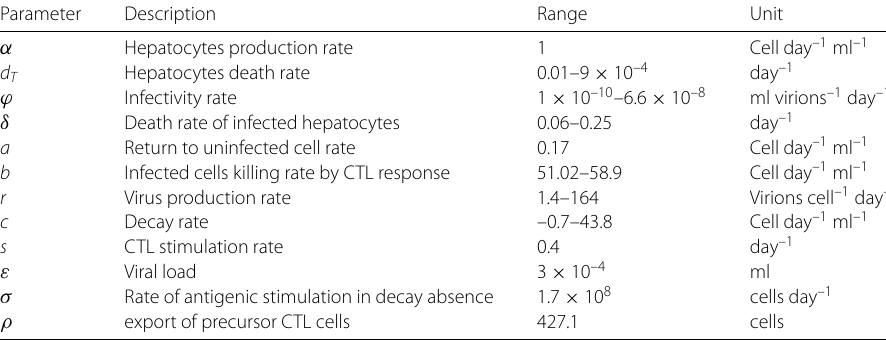
Table 1 The parameter values of the proposed